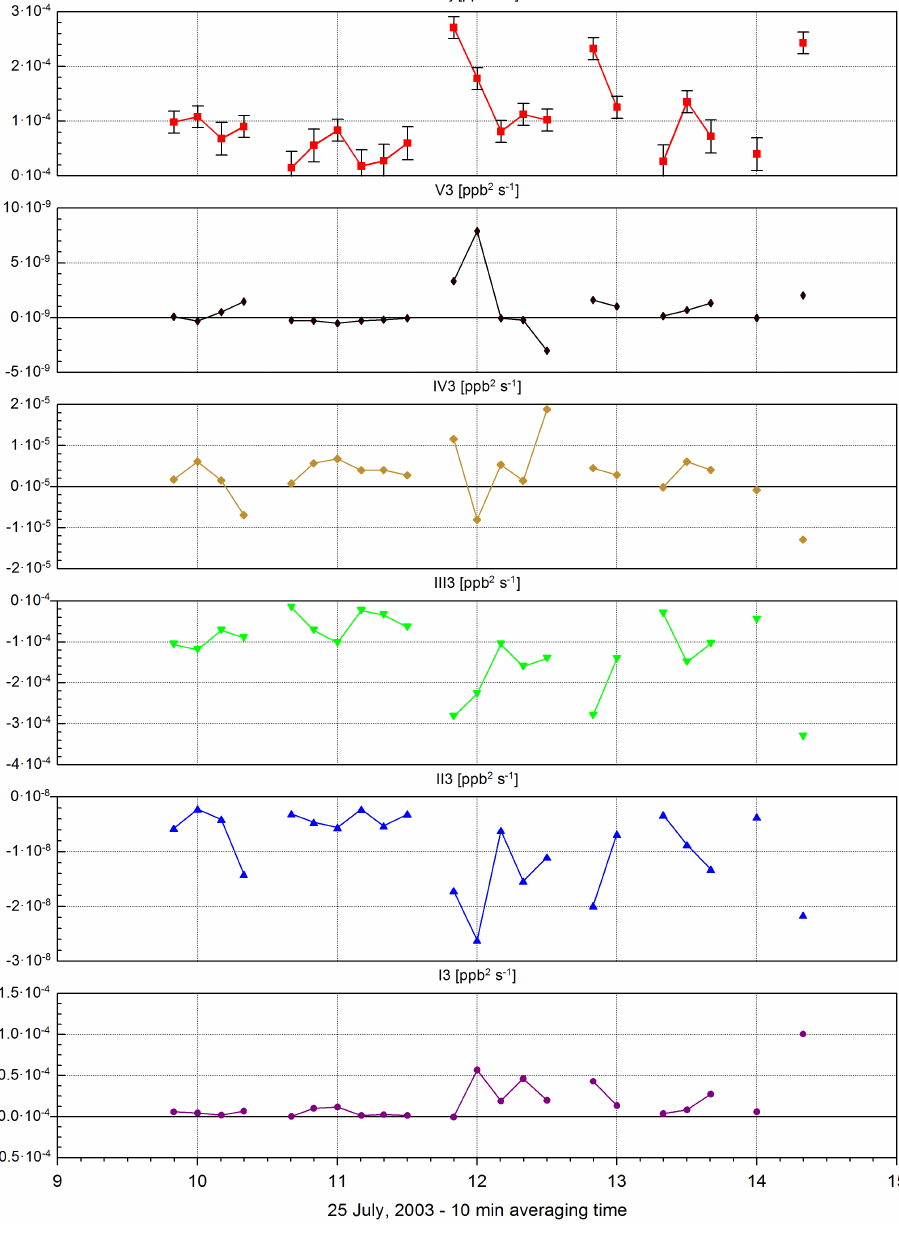
Figure 12. The chemical reaction terms (I3–V3) from Eq. 10 as explained in the text and in Table 4 and the sum R ij of Eq. (10) for day 206 (25 July 2003) of ECHO 2003 at the main tower z R =